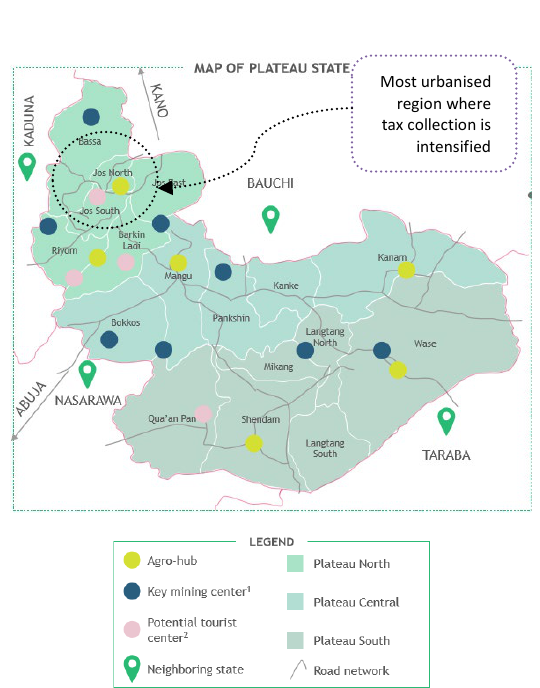
Fig. 1. Map of Plateau State (adapted from PSG, 2019d, p.